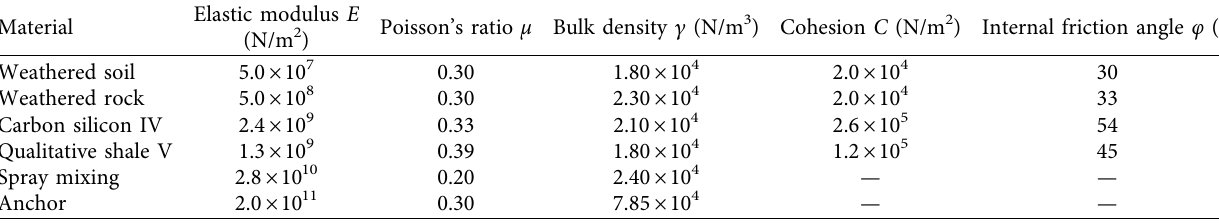
Table 3: Material parameters of the tunnel model.